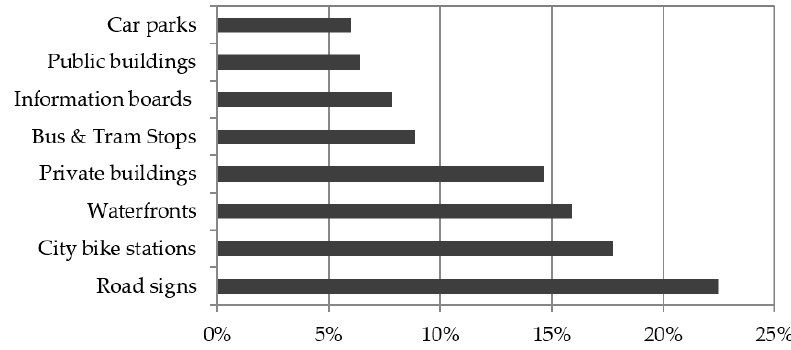
Figure 8. Breakdown of answers to the question “Have you seen renewable energy installations within the city of Bydgoszcz?” Source: own study.